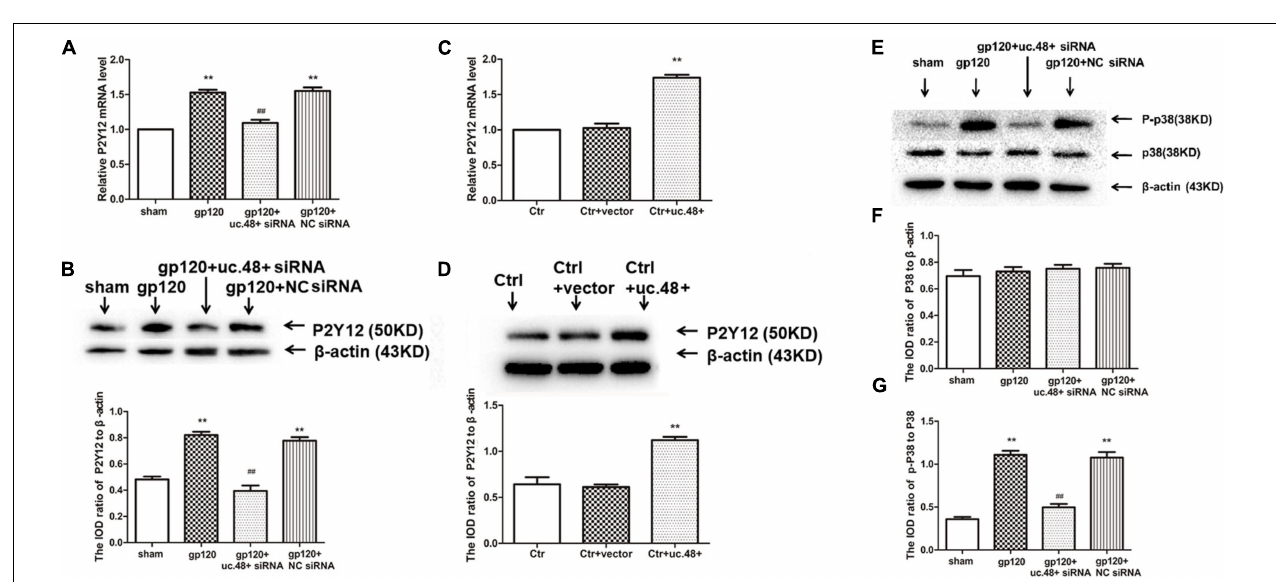
FIGURE 3 | Overexpression of uc.48+ by intrathecal injection induced pain behaviors in control rats. (A) Real-time PCR analysis showed that rats treated with uc.48+ had higher expression of uc.48+ compared with control group. Overexpression of uc.48+ lowered MWT (B) and TWL (C) . n = 8 rats per group. Data are displayed as means ± SEM. ∗∗ p < 0.01 vs. control group.